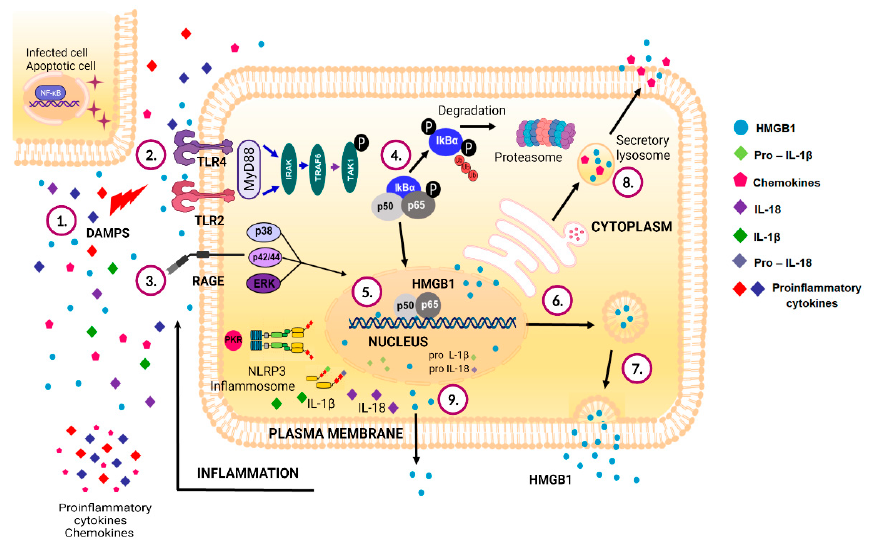
Figure 2. Mechanisms of intracellular mobilization and release of the HMGB1 protein. 1. HMGB1 protein and some molecules are released by cells, acting as alarmins (DAMPs) during apoptosis or necrosis, inducing cell activation and releasing proinflammatory molecules. 2. HMGB1 protein in- teraction with Toll-like receptors (TLR2 and TLR4) leads to the activation of MyD88-dependent sig- naling pathways. 3. Binding of HMGB1 to RAGE induces the activation of signaling pathways me- diated by p38 protein, p42/44 complexes, and ERK family proteins, inducing the activation of tran- scription factors. 4. NF-kB activation is induced by the interaction between HMGB1 and its recep- tors. 5. HMGB1 protein in the nucleus acts as a DNA-binding protein and as a regulatory protein during replication, transcription, and DNA repair. 6. Cell activation induces HMGB1 translocation from the nucleus to the cytoplasm. 7. In immune cells, HMGB1 is transported from the cytoplasm